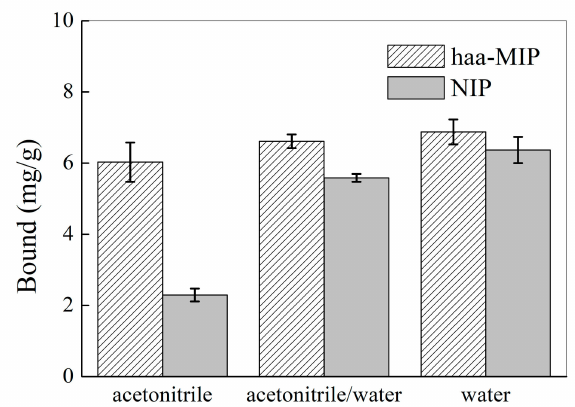
Figure 9. Equilibrium binding of the haa-MIP and NIP nanospheres toward harmine (20 mg/L) in acetonitrile, acetonitrile/water ( v / v 50/50), and